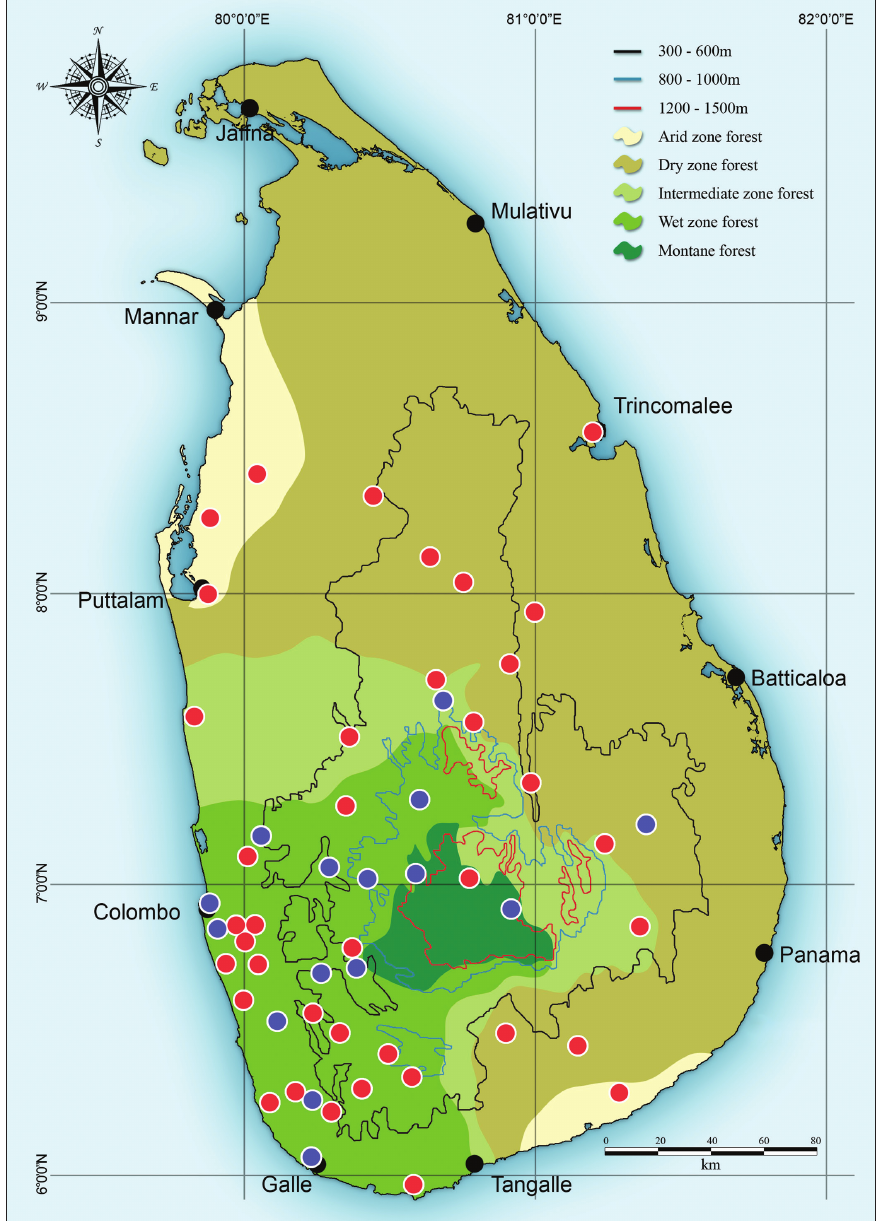
Figure 3. Distribution pattern of Oligodon sublineatus : blue dots, previous records and red dots, our observations; major towns are displayed on the map (map source: Cooray